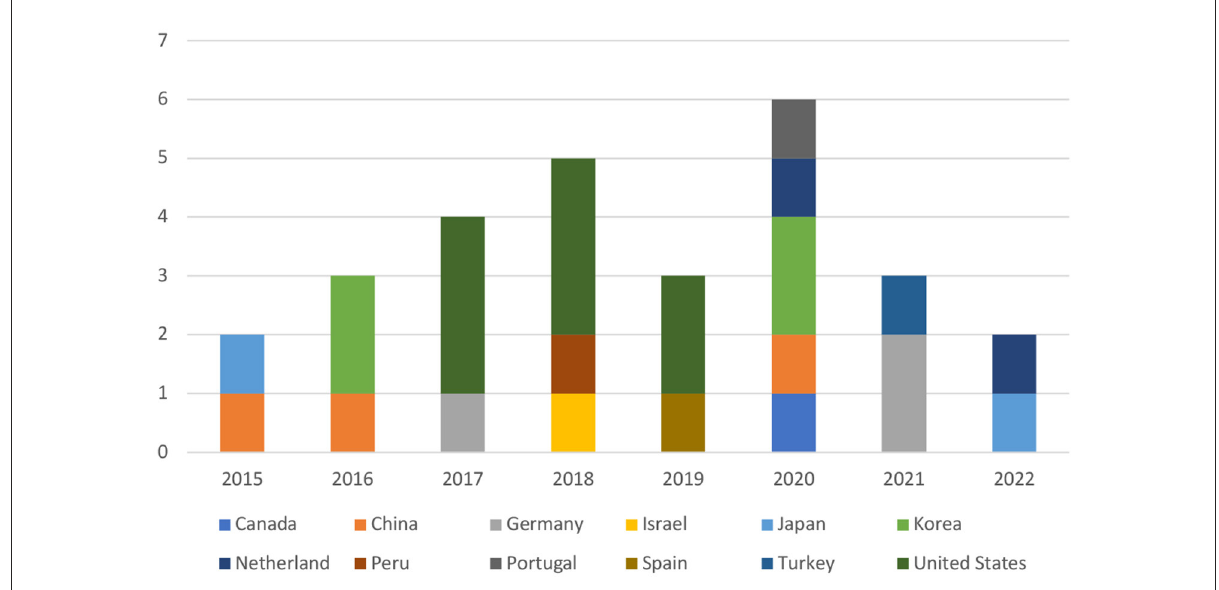
FIGURE3 Timeline of publication by the geographic area between 2015 and 2022.